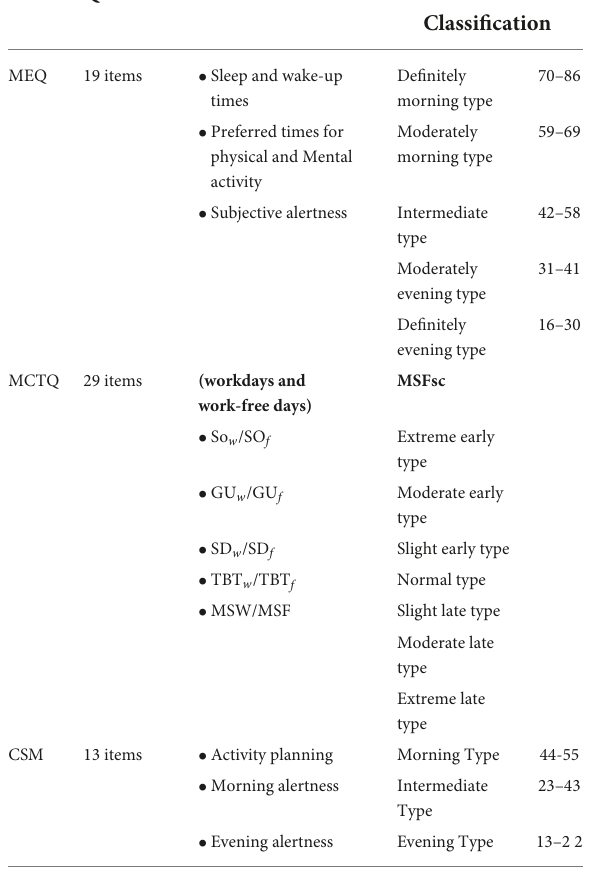
TABLE 1 Questionnaires for